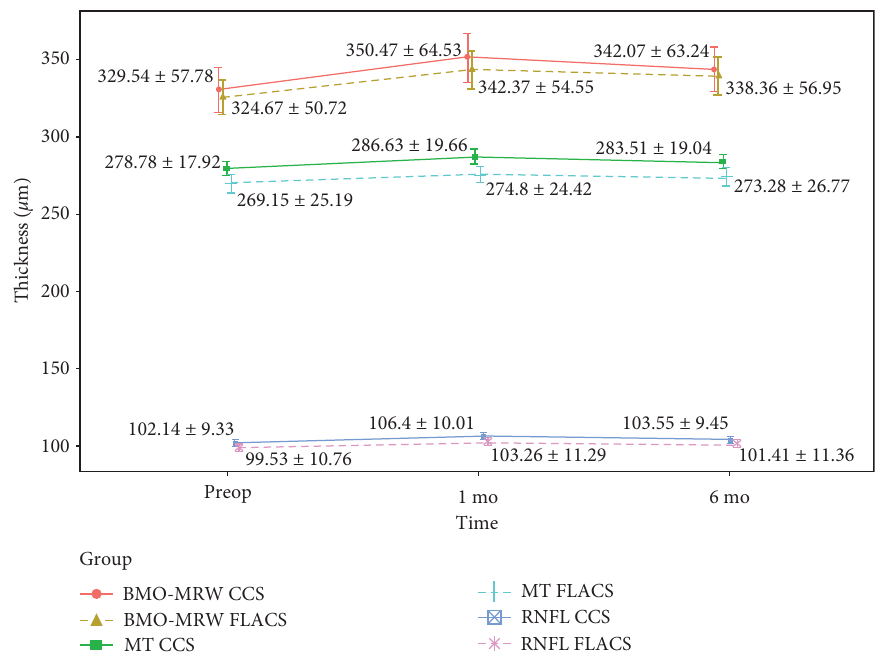
Figure 1: BMO-MRW, RNFL and MT at all visits in CCS and FLACS groups. BMO-MRW � Bruch’s membrane opening minimum rim width. RNFL � peripapillary retinal nerve fber layer. MT � macular thickness. CCS � Conventional cataract surgery. FLACS � femtosecond laser-assisted cataract surgery. Preop � Preoperative. 1mo � 1month potoperative. 6 mo � 6months postoperative. Data are reported as mean ± SD.